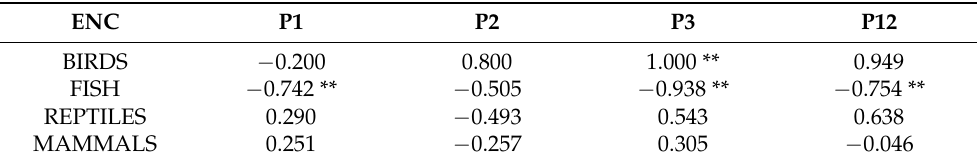
Table 3. Correlation analysis (Spearman rank) between overall ENC and P1, P2, P3, and P12 values of FoxP2 gene among fish, birds, reptiles, and mammals.